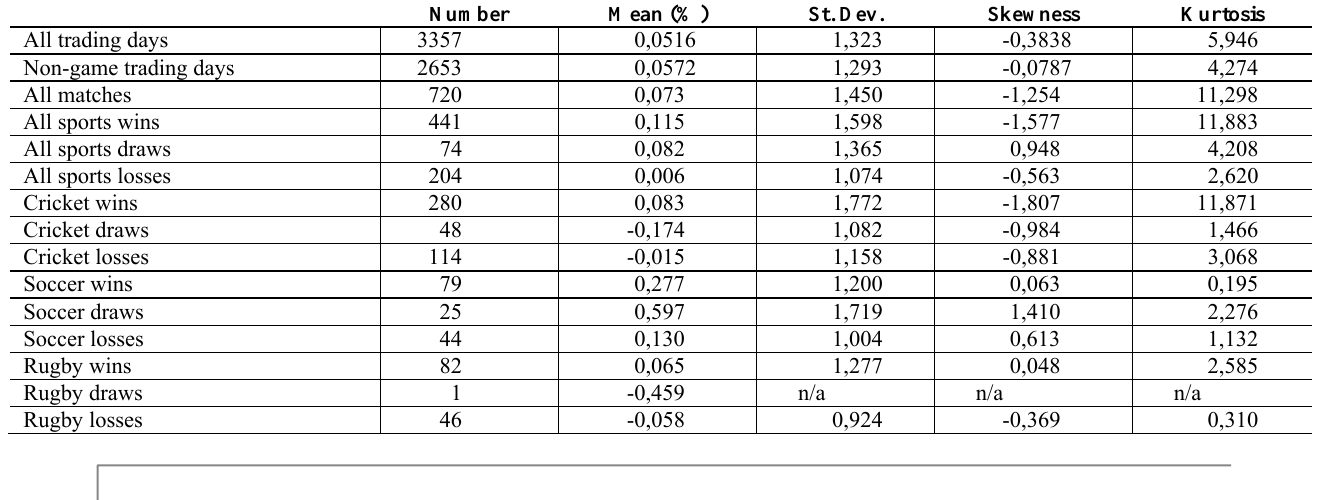
Table 1: Summary statistics of returns